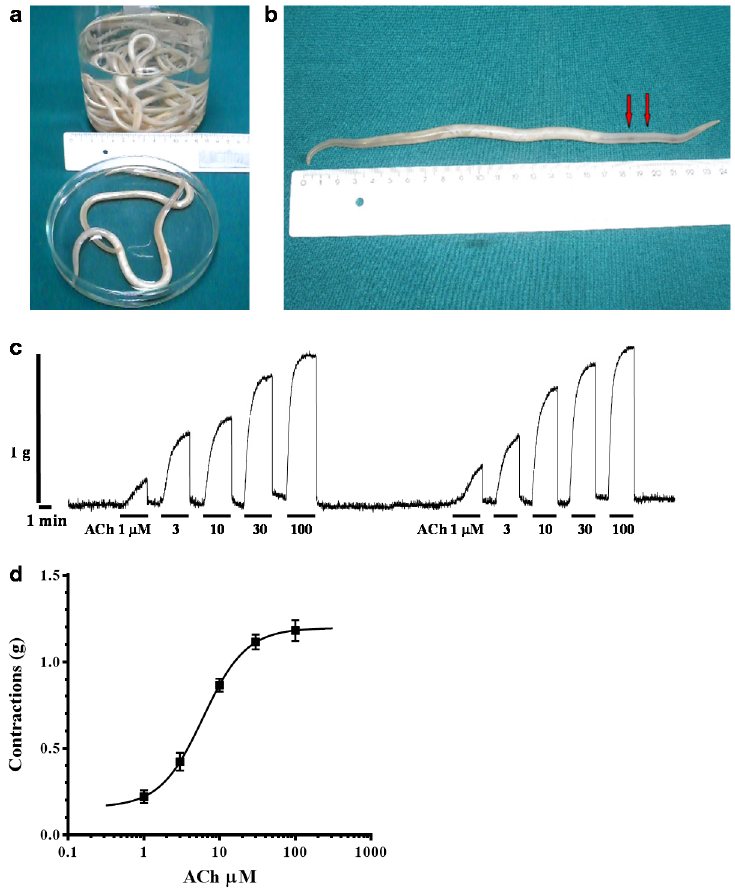
Figure 1. Contraction of Parascaris sp. muscle strips produced by acetylcholine. ( a ) Adult female Parascaris sp. collected from horses and used in this study; ( b ) photograph of a single worm indicating the location of the body muscle flap (1 cm length between the two red arrows), within the anterior part of the worm (3–4 cm caudal to the head), to be dissected for isometric contraction measurements; ( c ) isometric contractions of Parascaris sp. muscle flap produced by increasing concentrations of acetylcholine (ACh) from 1 to 100 µM (short bars); ( d ) concentration–response plot for ACh fitted with non-linear regression, with mean contraction in g ± SE ( n = 5).